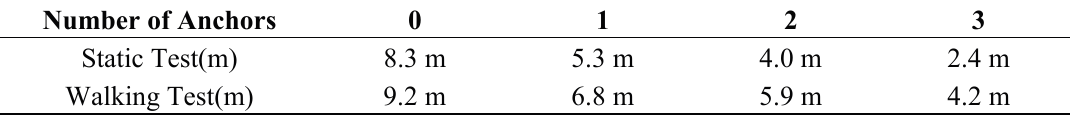
Table 4. Average positioning error vs. Anchor number in scenario one (MI